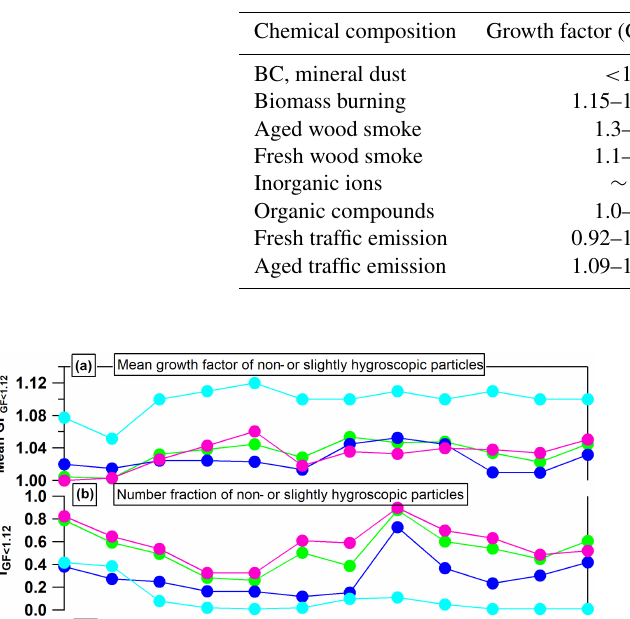
Table 1. Mean growth factors measured at RH = 90% for particles with different chemical compositions.